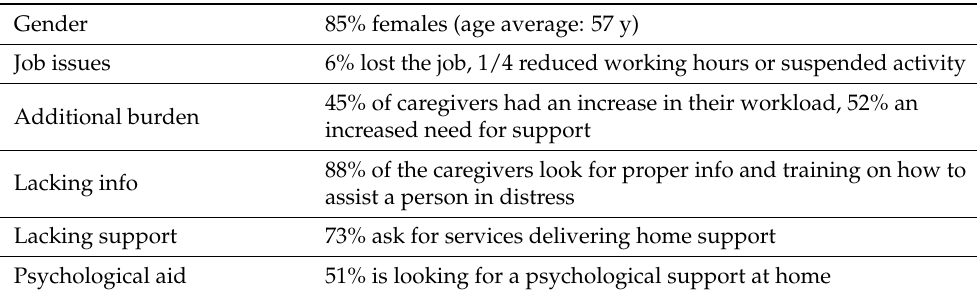
Table 2. Summary of the outcome of the ‘Caregivers after the pandemic’ survey carried out in northern Italy